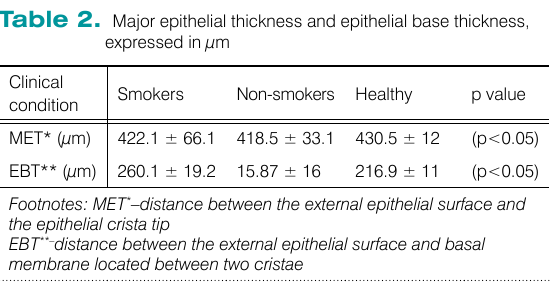
Table 3. External and internal epithelial parameter in smokers and non-smokers (µm)